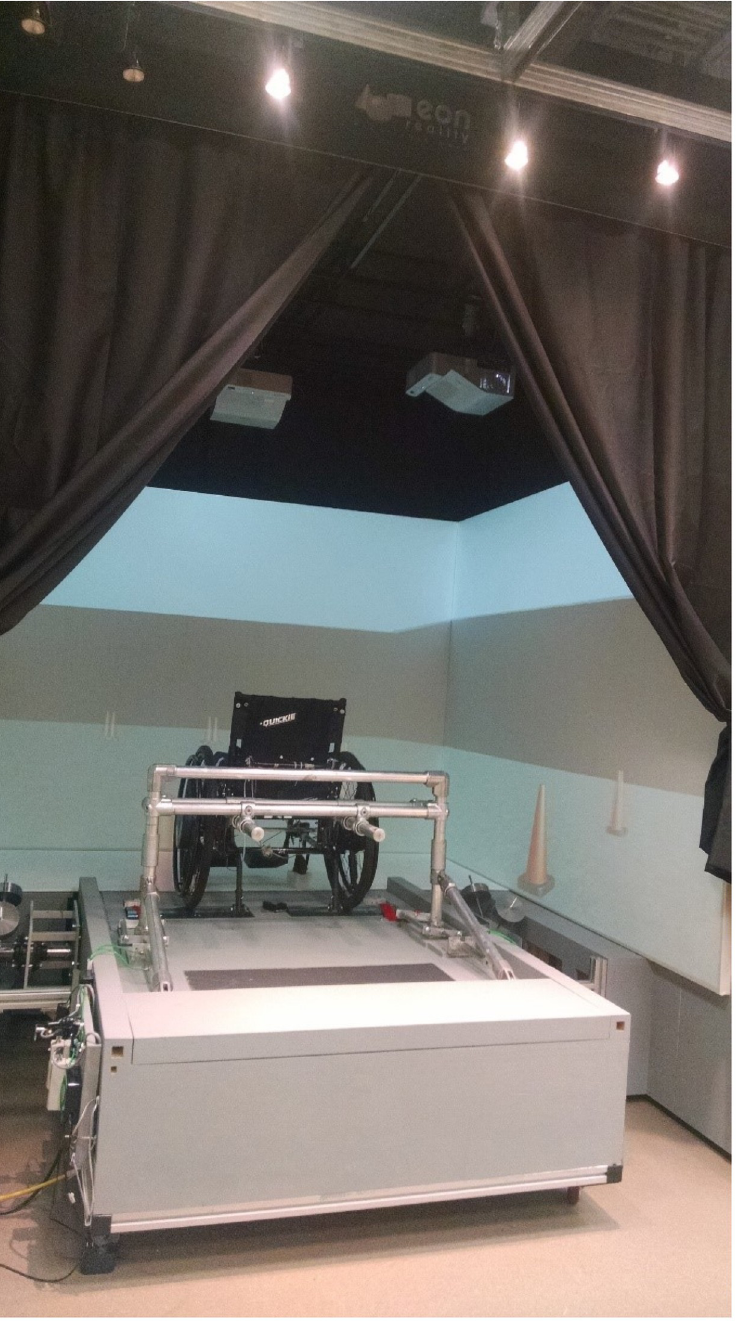
Fig 1. Wheelchair ergometer inside EON IcubeTM